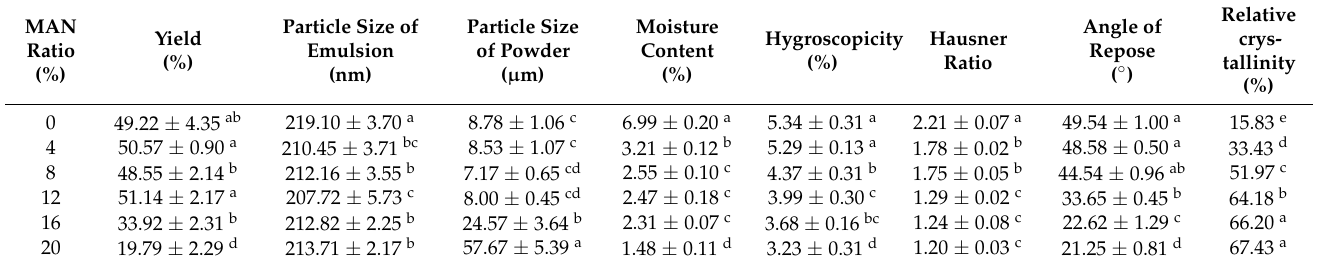
Table 2. Chemical properties of HP- β -CD/MAN microcapsules with different MAN